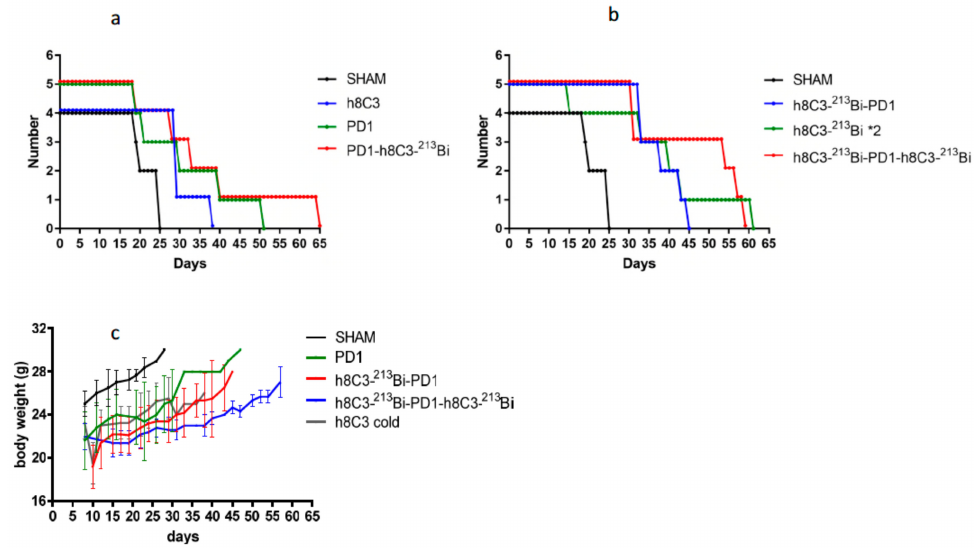
Figure 4. Survival and body weight of Cloudman S91 tumor bearing male DBA / 2 mice treated with anti-PD-1 mAb and two RIT with 213 Bi-h8C3 mAb: ( a ) sham, cold h8C3, three doses of anti-PD-1, and combination of three doses of anti-PD-1 mAb with one dose RIT with 213 Bi-h8C3 mAb; ( b ) sham, combination of one dose RIT with 213 Bi-h8C3 mAb followed with three doses of anti-PD-1 mAb, two doses of RIT with 213 Bi-h8C3 mAb, and two doses of RIT with 213 Bi-h8C3 mAb combined with three doses of anti-PD-1 mAb; ( c ) body weight of treated